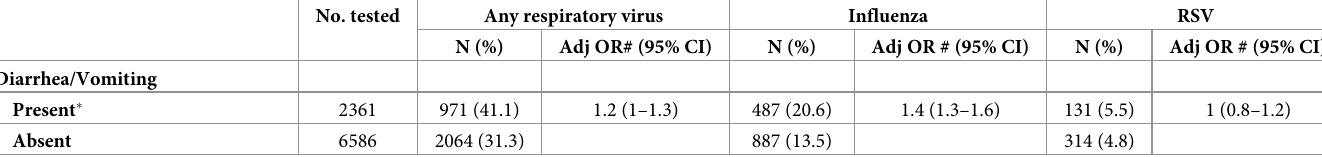
Across all centers, respiratory viruses were detected in 2,981 (33.3%) ARI and 2,468 (33.4%) SARI cases. Virus detection in ARI cases ranged from 17.4% in Chennai to 53.2% in Srinagar (Table 1), while in SARI, virus detection ranged from 27.7% in Srinagar to 41.6% in Delhi (Table 2). Viral detection was highest among children aged 2–4 years (47.4% in ARI and